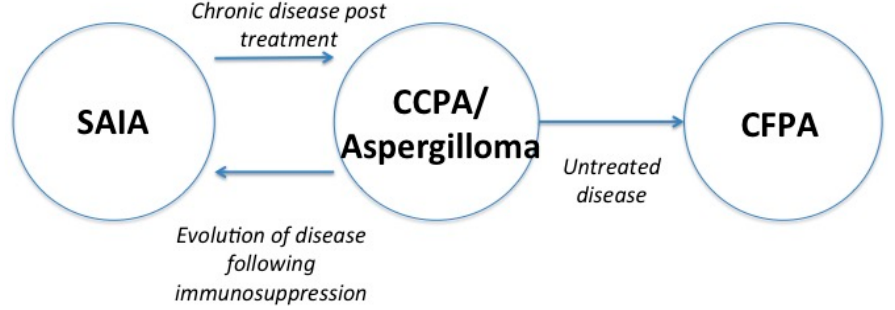
Figure 1. Forms of chronic pulmonary aspergillosis (SAIA: subacute invasive aspergillosis, CCPA: chronic cavitary pulmonary aspergillosis, CFPA: chronic fibrosing pulmonary aspergillosis).